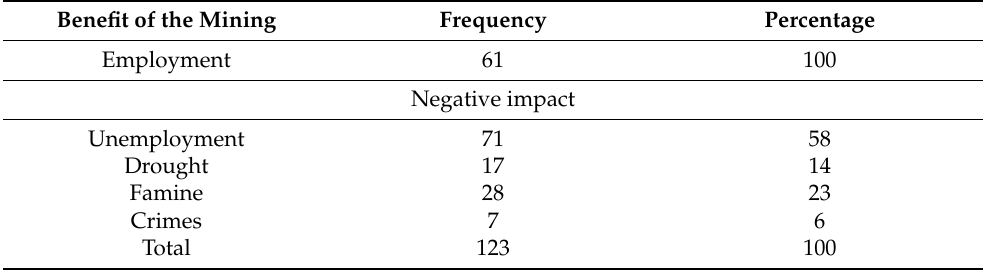
Table 4. Positive and negative impacts of mining in the forest reserve on livelihoods. Benefit of the Mining Frequency Percentage Employment 61 100 Negative impact Unemployment 71 58 Drought 17 14 Famine 28 23 Crimes 7 6 Total 123 100